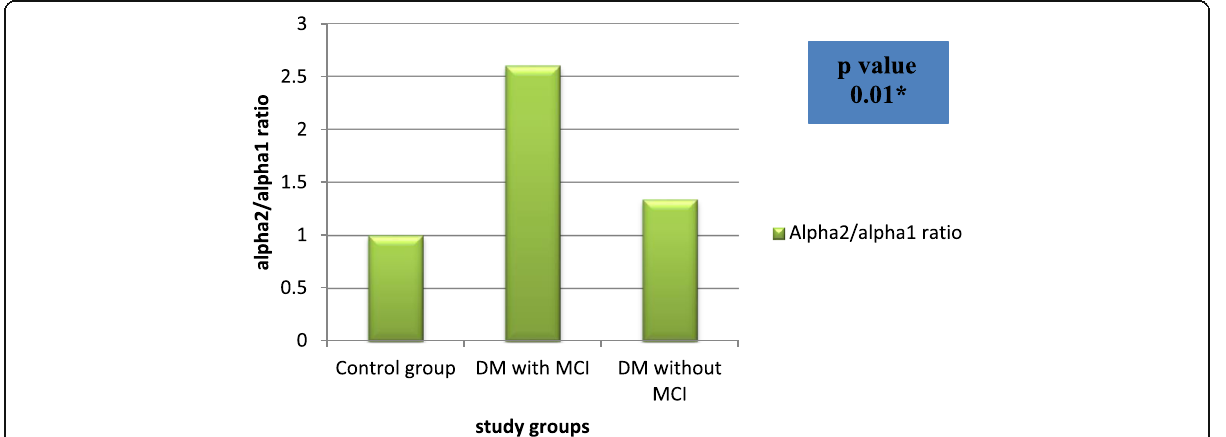
Fig. 1 Distribution of alpha 2/alpha 1 power ratio among the study groups. DM = diabetes mellitus, MCI = mild cognitive